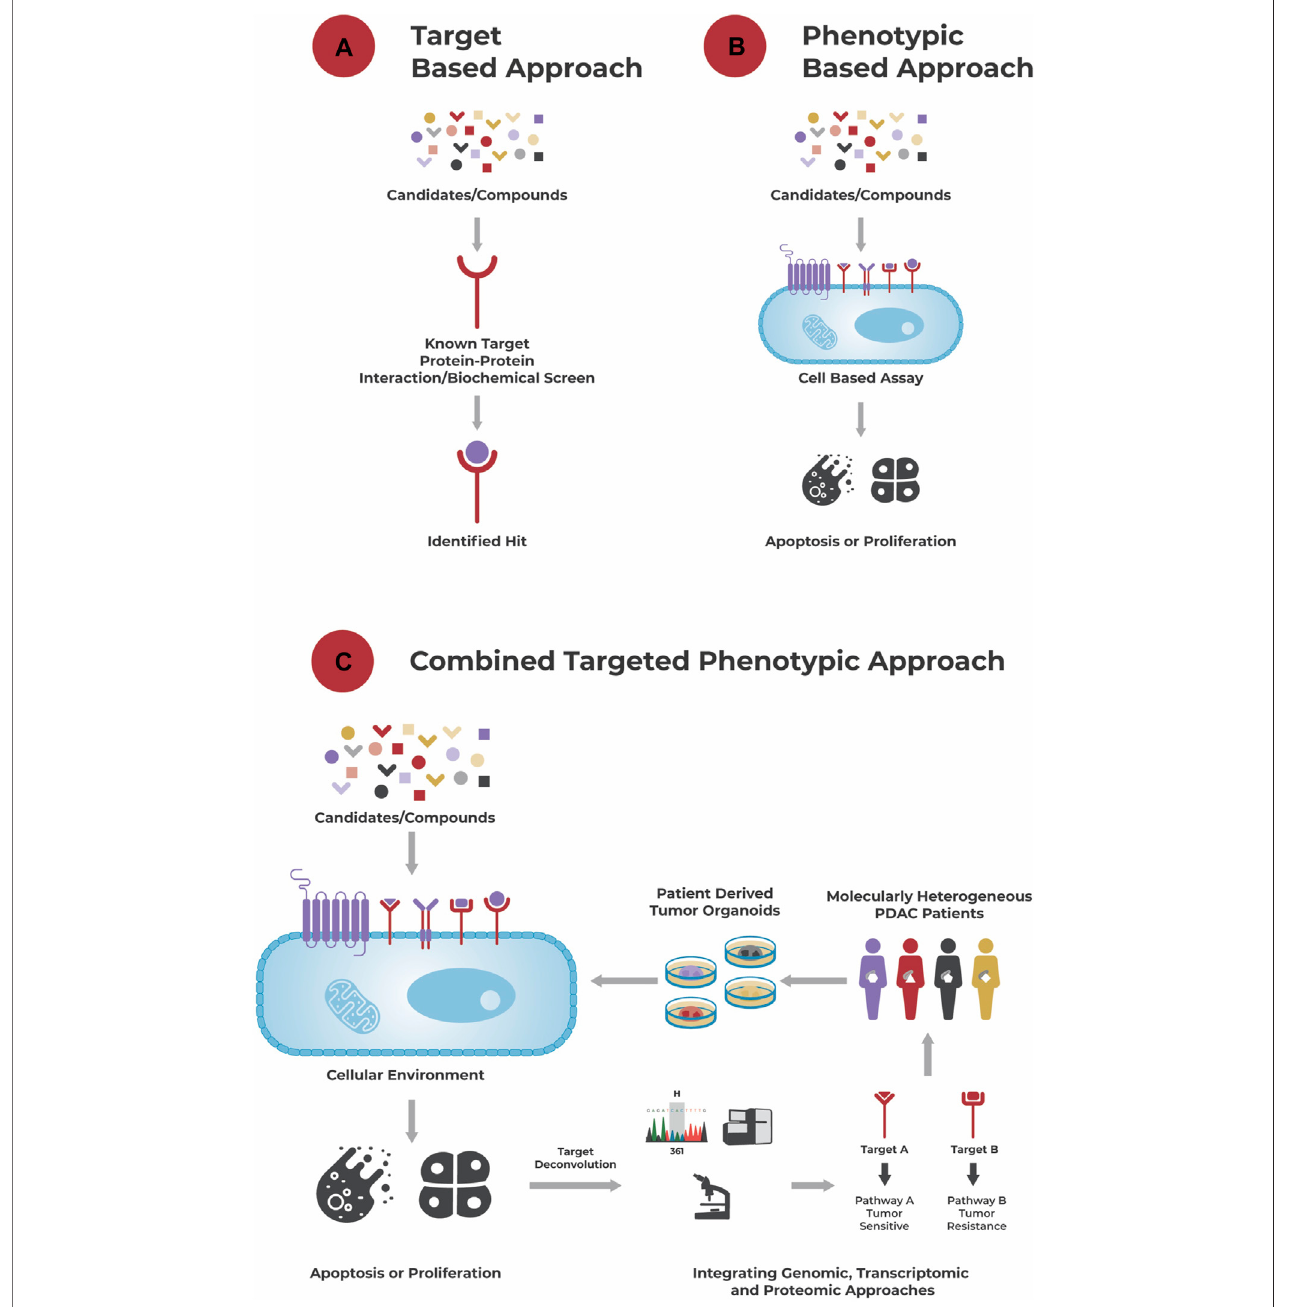
FIGURE 1 | Different approaches to drug discovery. (A) : A target-based approach aims to identify a hit to a known target using a biochemical screen. (B) : A phenotypic-based approachidenti fi eshitsbasedontheireffectinacell-basedassay,e.g.,theirabilitytoinduceapoptosisorgrowth arrest,withoutnecessarily knowing the compound ’ s biochemical target and its role in disease biology. (C) : A combined targeted phenotypic approach leverages both, a target-based and phenotypic approach.Theeffectofcompoundsistestedinacellularenvironmentandhitsselectedbasedontheireffectonthecells ’ phenotype.Apowerfulmodelsystemhere are patient-derived organoids that recapitulate the genetic and molecular alterations of a patient ’ s tumor, and which are for example used in the approach of Reversed Clinical Engineering ® . Then, using target deconvolution strategies like the integration of genomic, transcriptomic, and proteomic data, mechanisms (induced by the “ hits ” ) conferring to drug sensitivity and/or resistance and suitable compounds for treatment can be identi fi ed for each individual patient tumor.